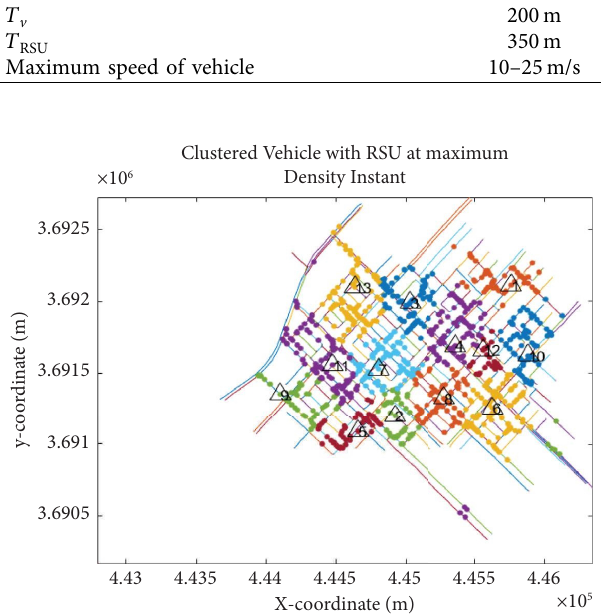
Figure 5: Clusters formation along with RSU deployment with maximum vehicle